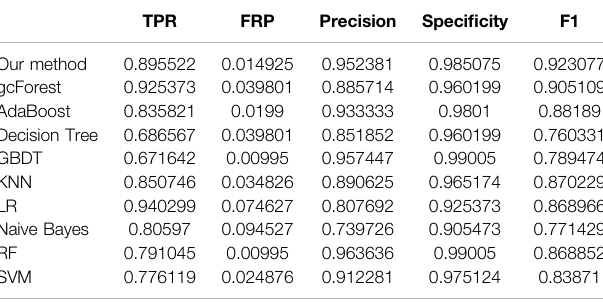
TABLE 5 | Classi fi cation performances of ten methods with 10-cross validation methods.